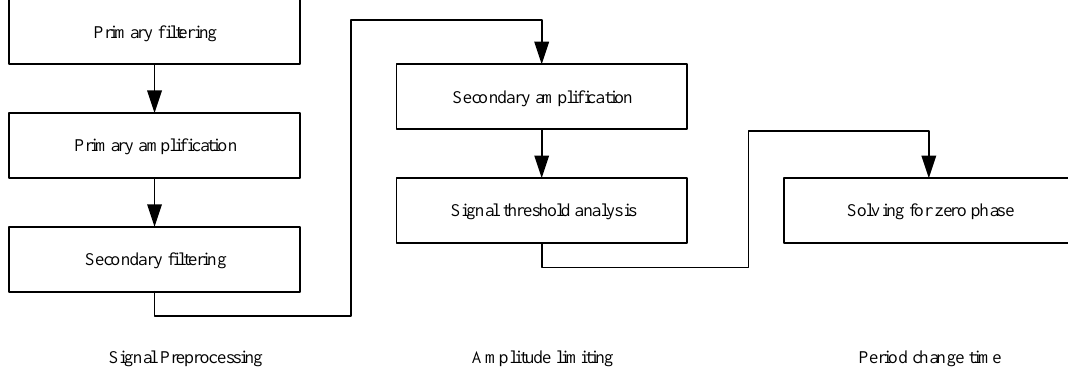
Figure 3. Flow process of electronic signal threshold analysis.